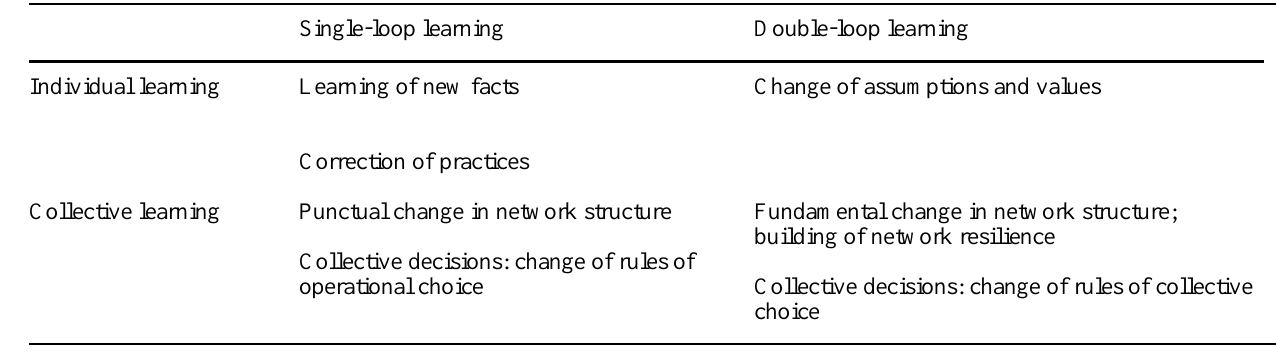
Table 1. Relation of single- and double-loop learning to individual and collective